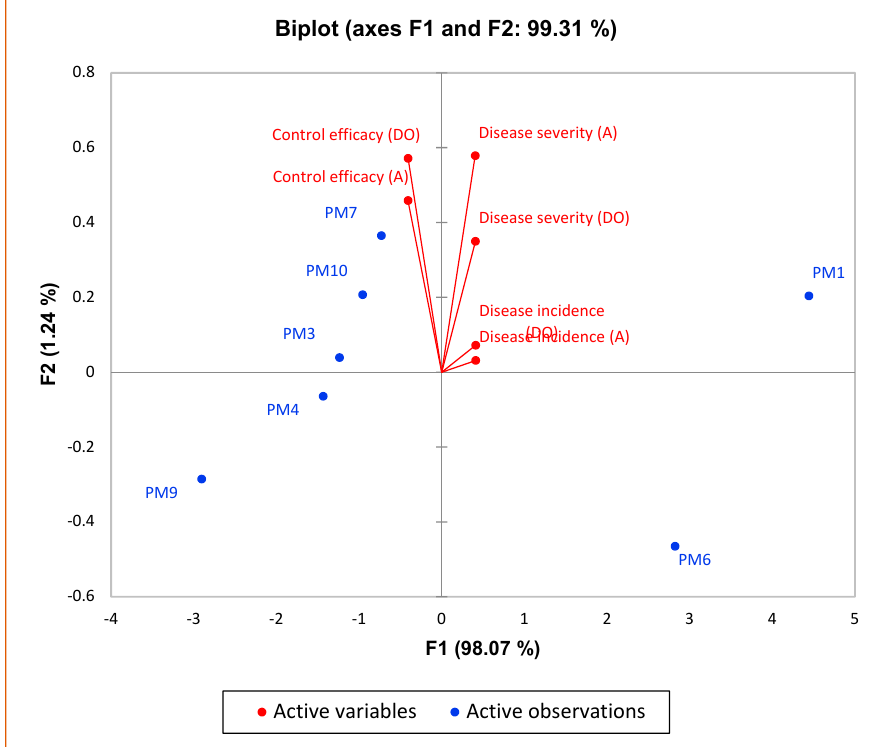
Figure 7. Principal component analysis (PCA) for control of damping off and anthracnose. DO—damping off, A—anthracnose.